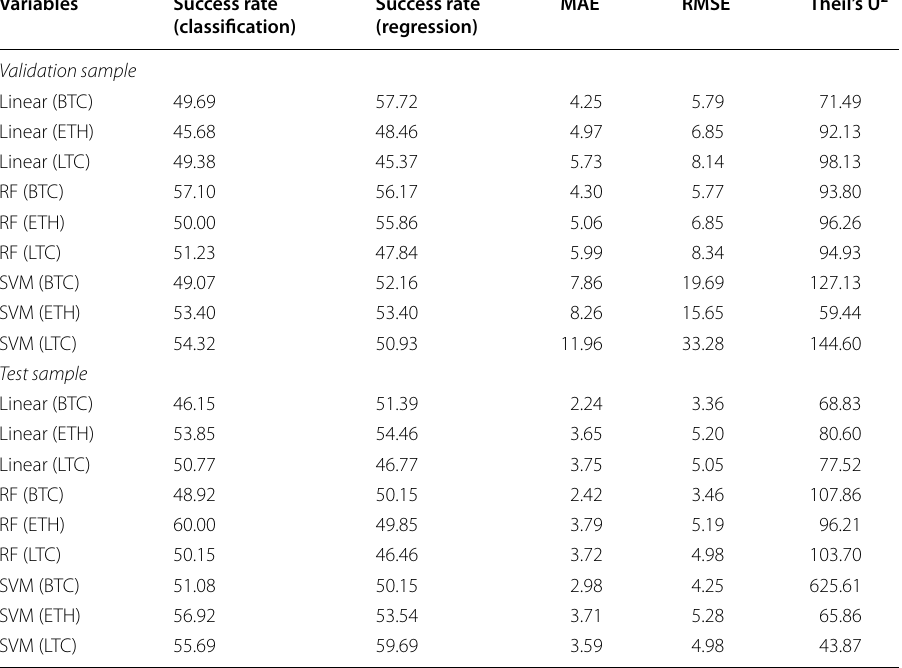
Table 6 Forecasting ability of the